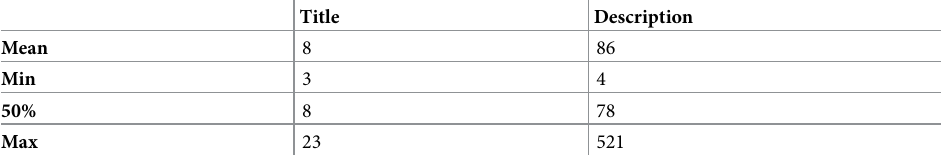
Table 2. Word count summary for RFA.